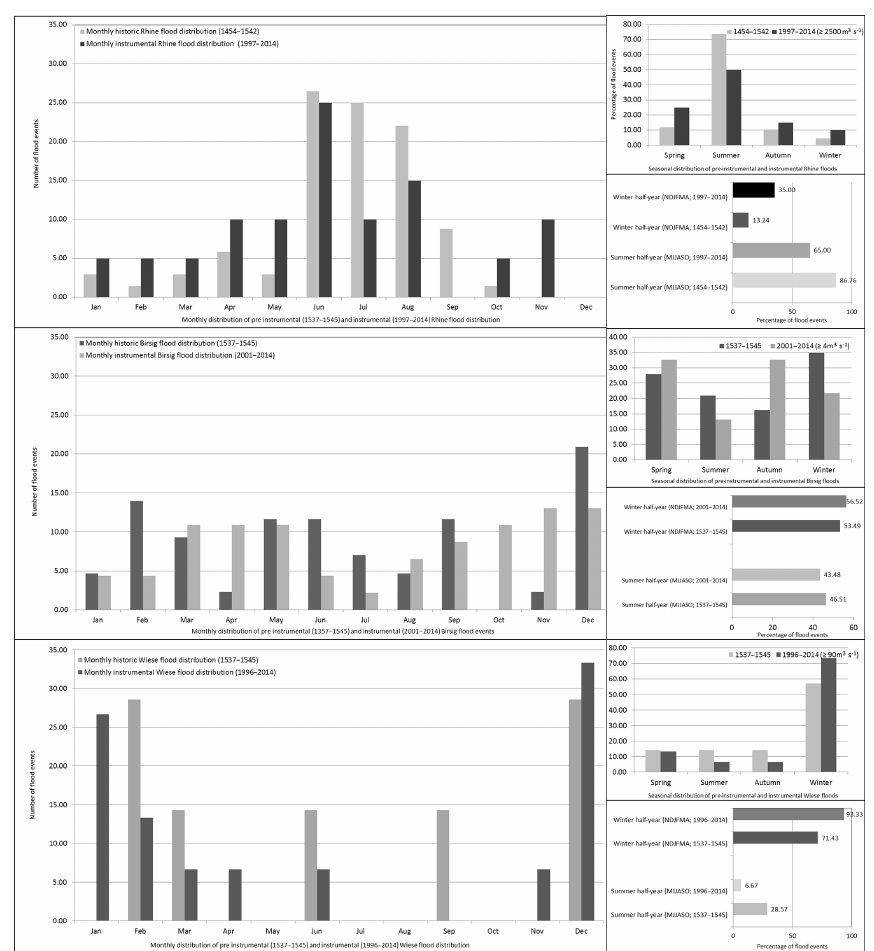
Figure 17. Distribution of historical and instrumental Rhine, Birsig and Wiese flood events in